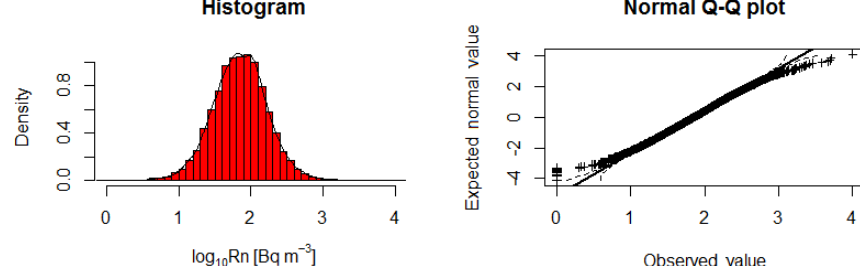
Figure 2. Histogram and q–q plot of average indoor radon concentration (AM_z) on the ground floor of dwellings.